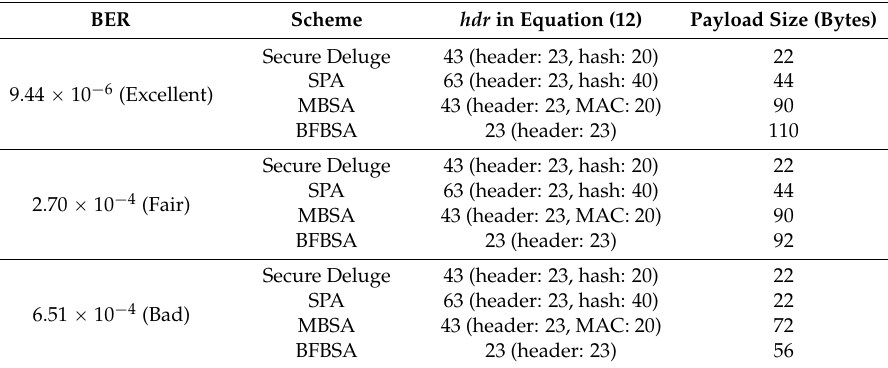
Table 2. Optimal Payload